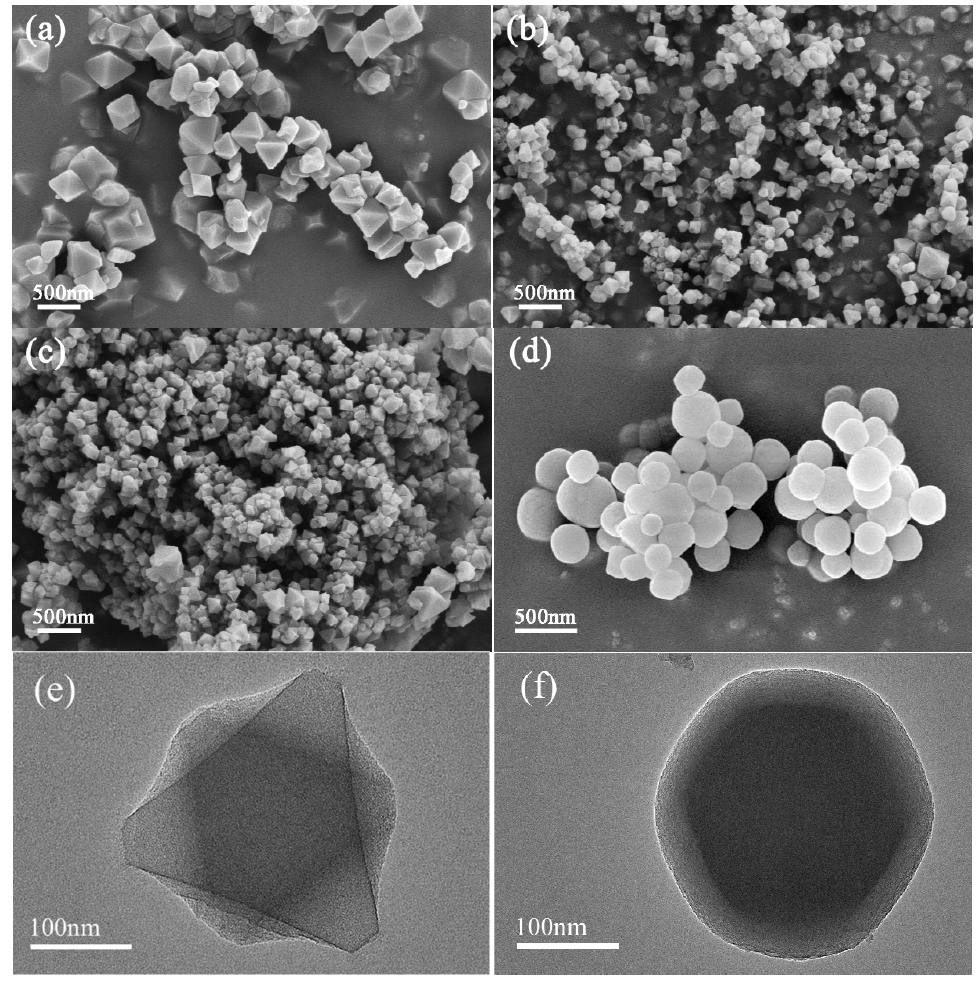
Figure 1. SEM images of ( a ) 220-MIL-101, ( b ) 200-MIL-101, ( c ) 180-MIL-101, and ( d ) 160-MIL-101. HRTEM images of ( e ) 200-MIL-101 and ( f ) 160-MIL-101.